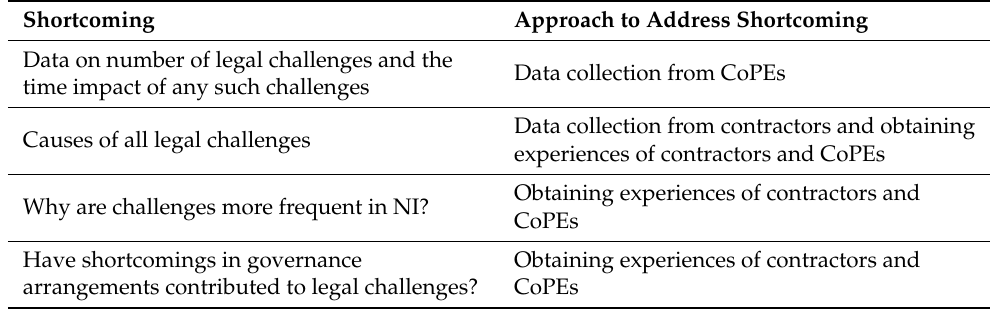
Table 3. Proposed method of researching